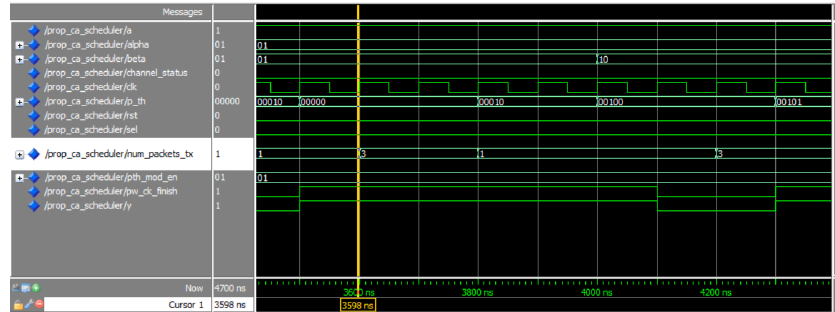
Figure 13. simulation of the proposed channel aware scheduler. Figure 13. Simulation of the proposed channel aware